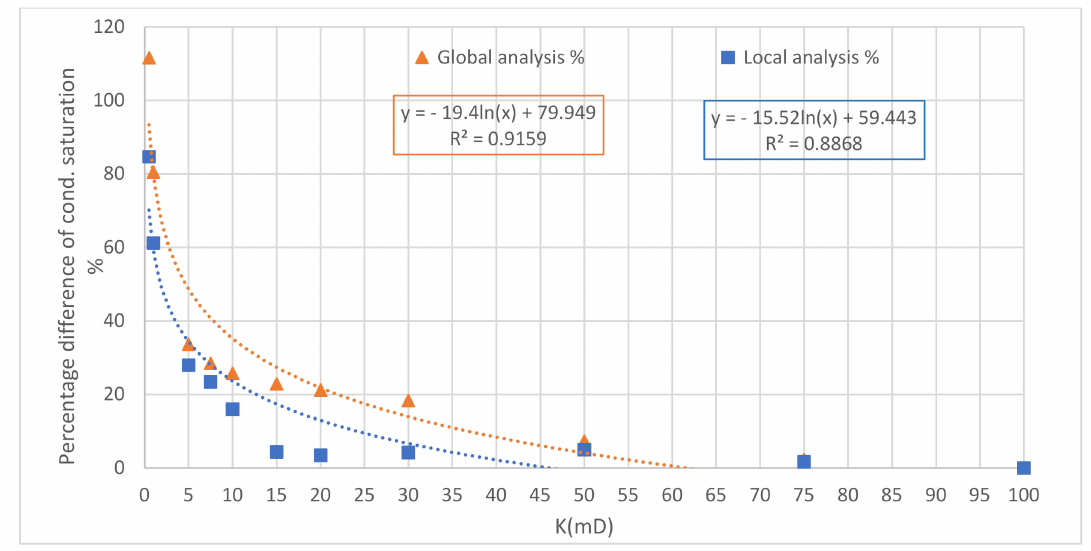
Figure 12. Comparison of percentage di ff erence in condensate saturation versus permeability for global and local